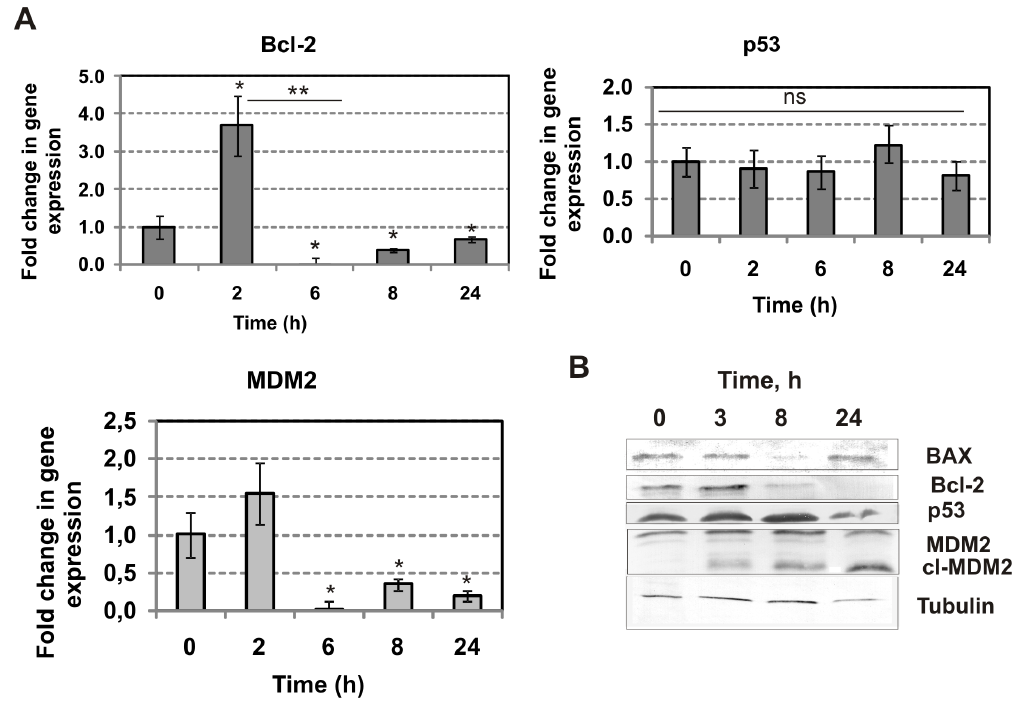
Figure 2. RL2 regulates activity of apoptosis-related genes. A . MDA-MB-231 cells were treated with RL2 (0.2 mg/mL) for the indicated time followed by total RNA isolation. Levels of transcripts were analysed by real time RT PCR with specific primers and were presented as relative values normalized to the level of GAPDH mRNA. n=3; the error bars represent standard deviations. The asterisks indicate significant difference from control (0 h), *p , 0.05, or between indicated groups, **p , 0.05, ns - not significant difference between groups (p . 0.05). B . MDA-MB-231 cells were treated with RL2 (0.2 mg/mL) followed by preparation of whole-cell lysates, which were then subjected to Western blot with the indicated antibodies. Tubulin was used as the internal control. Results shown are representative of five independent